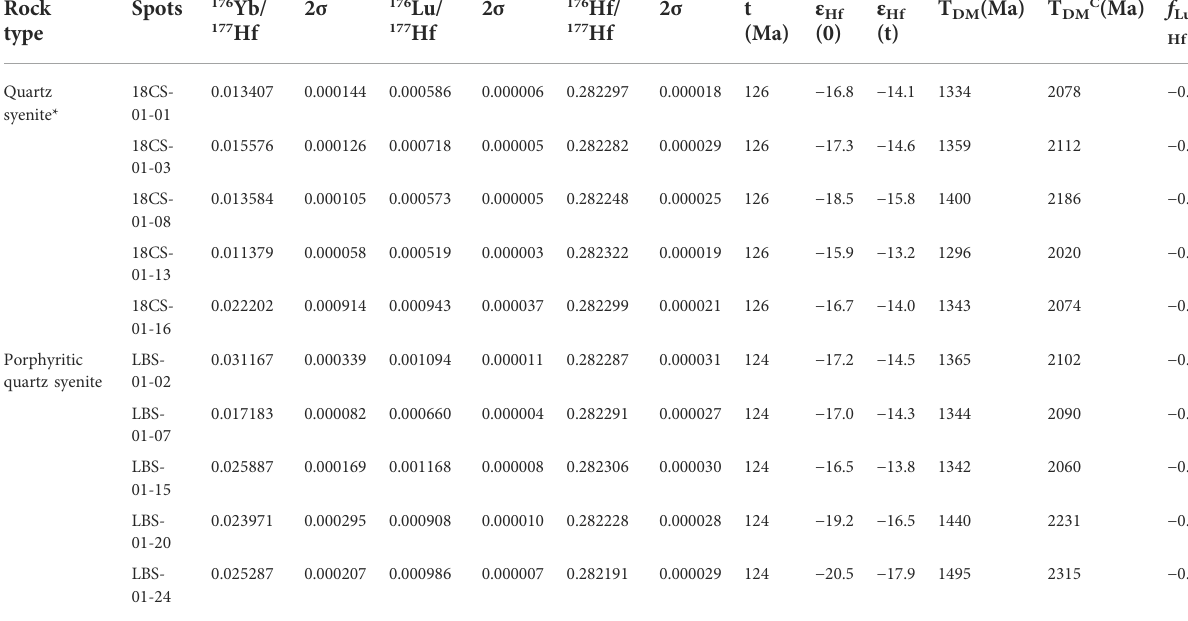
TABLE 4 Zircon Hf isotopic compositions of the quartz syenite from Chishan and Longbaoshan complexes.